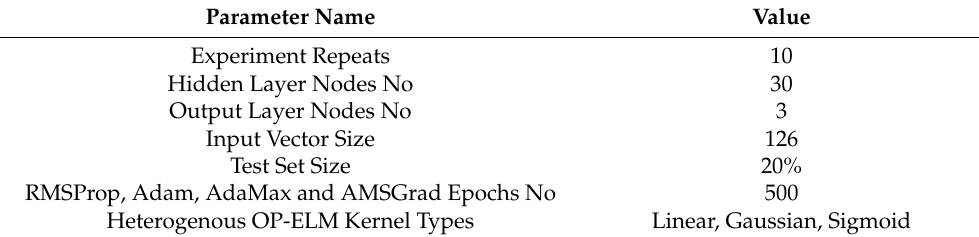
Table 1. Parameter Values.